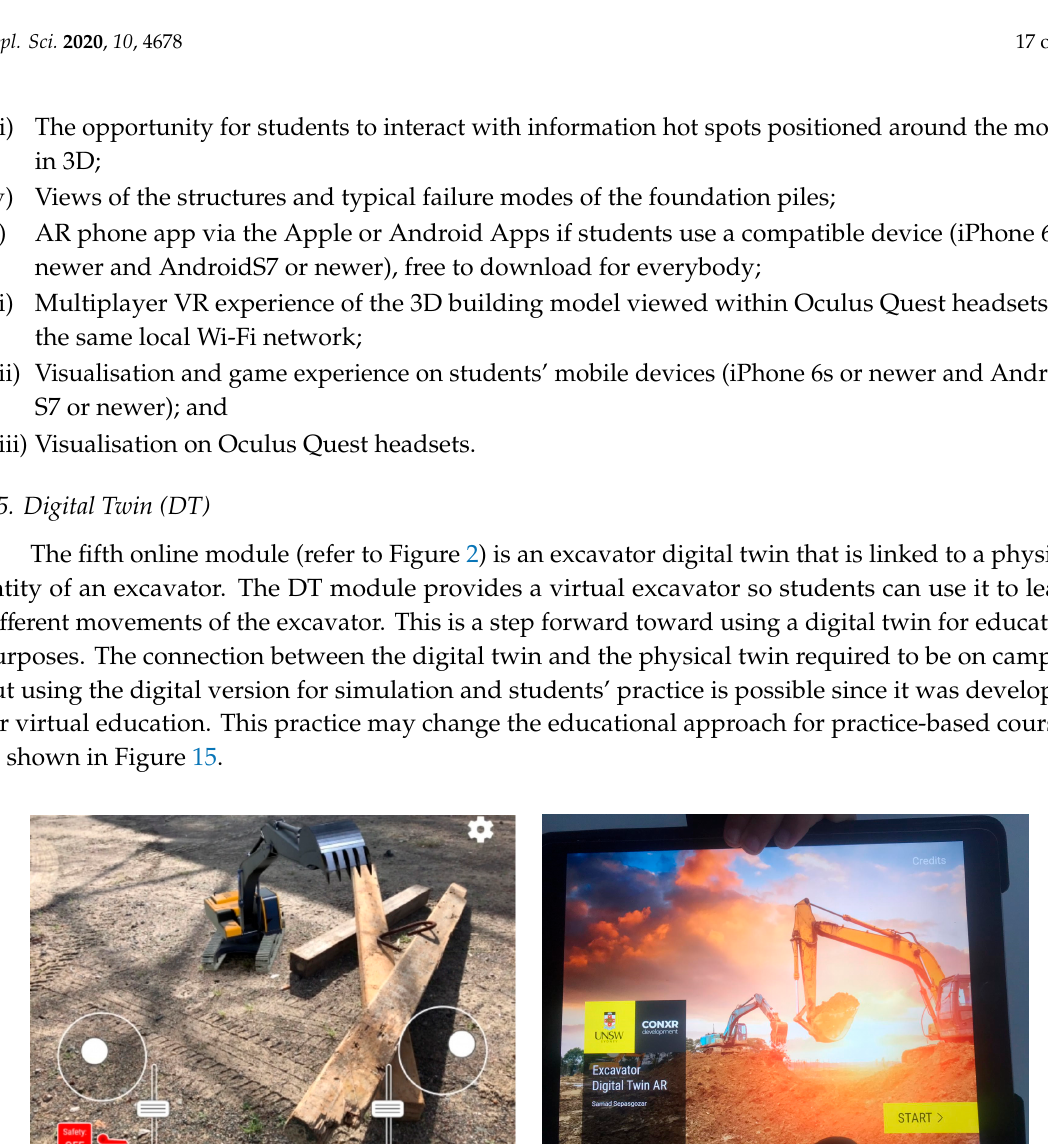
Figure 15. The digital twin AR of the chosen excavator. ( a ) the AR excavator running in the field (https://www.globalconstructionreview.com/innovation/australian-academic-develops-digital-twin- digger/); ( b ) the digital model on iPad.